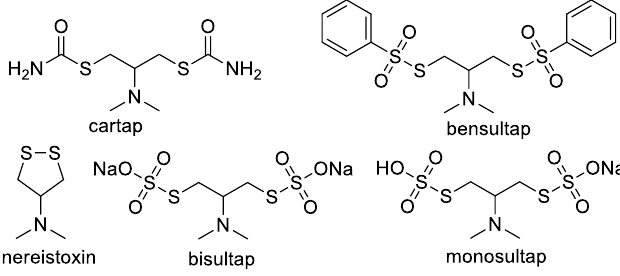
Figure 1. Chemical structures of cartap and its analogues.